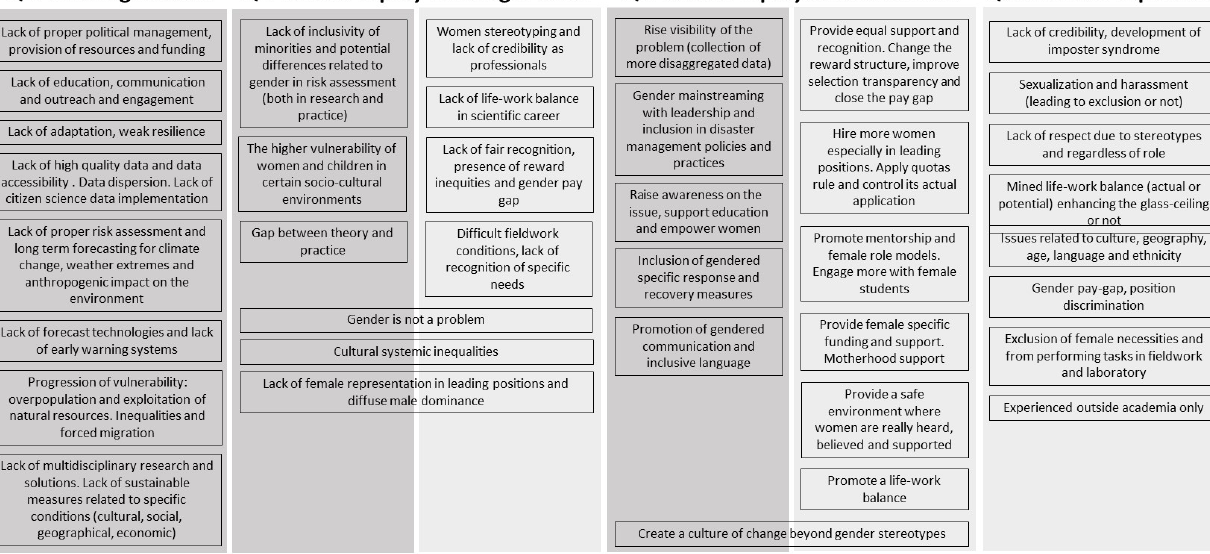
Figure 1. Summary of the categories of challenges and solutions in natural hazards (NH) related to gender equity and personal experiences. In dark grey are natural-hazard-related responses while in light grey are responses related to professional and career